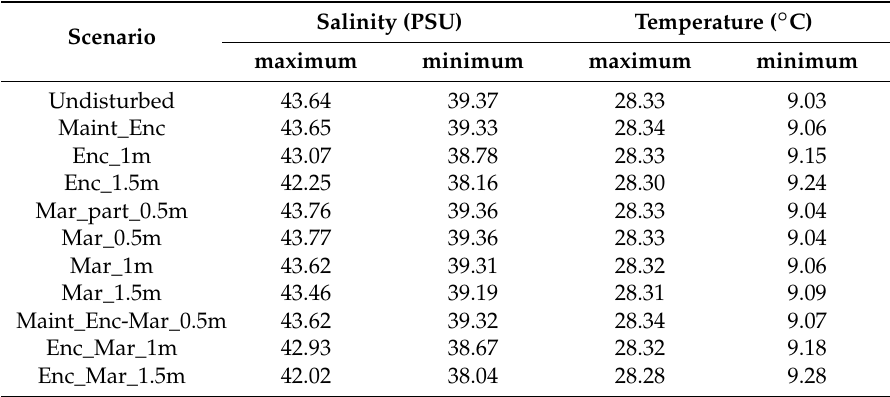
Table 7. Maximum and minimum annual salinity and temperature values from monthly averages over the